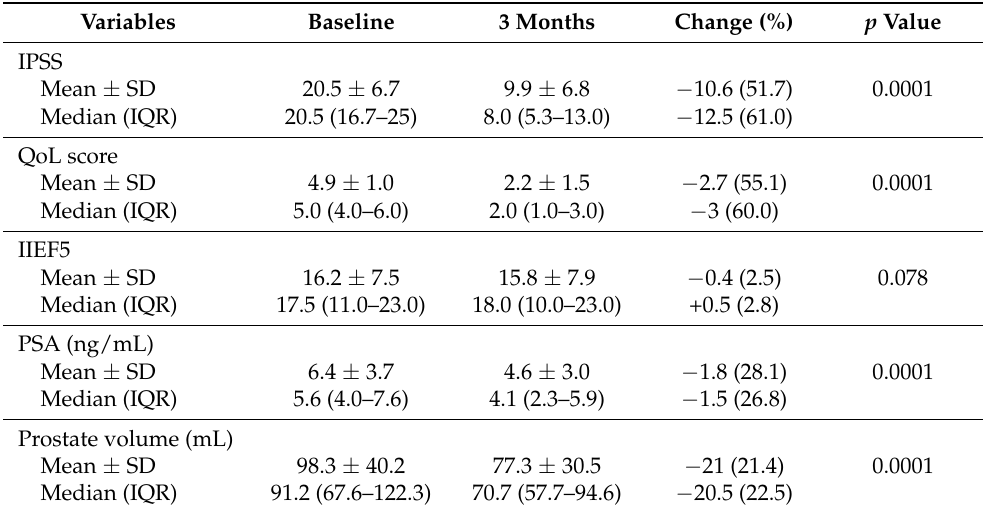
Table 3. PAE efficacy outcomes after 3 months.